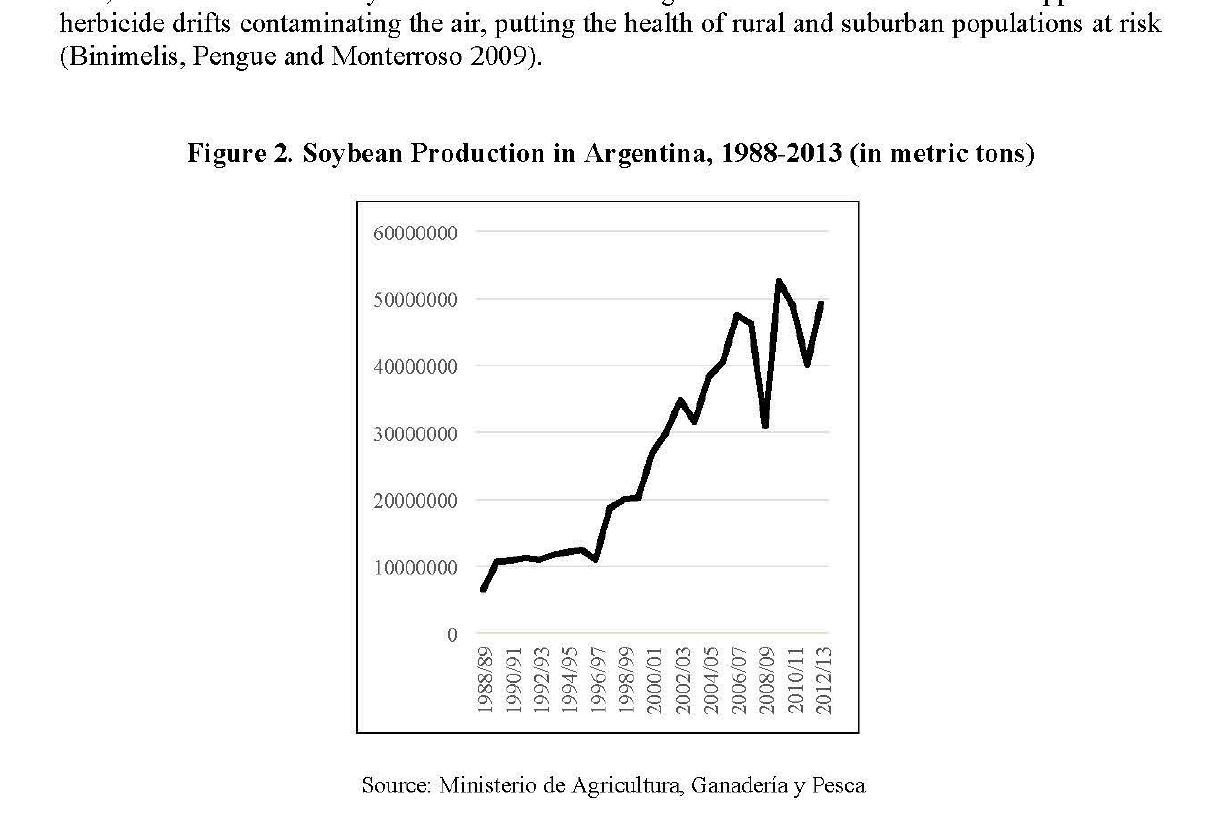
Figure 2. Soybean Production in Argentina, 1988-2013 (in metric